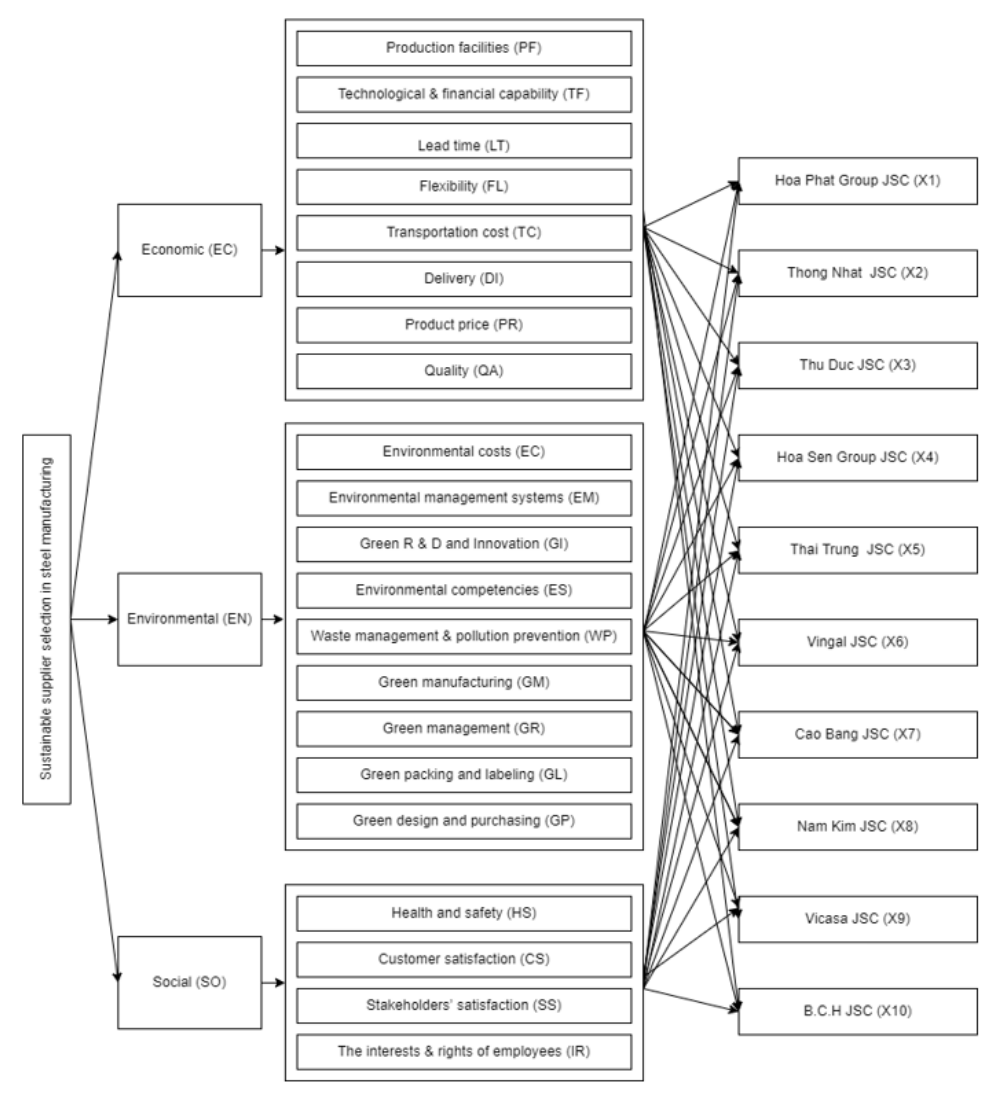
Figure 2. Proposed hierarchical framework.